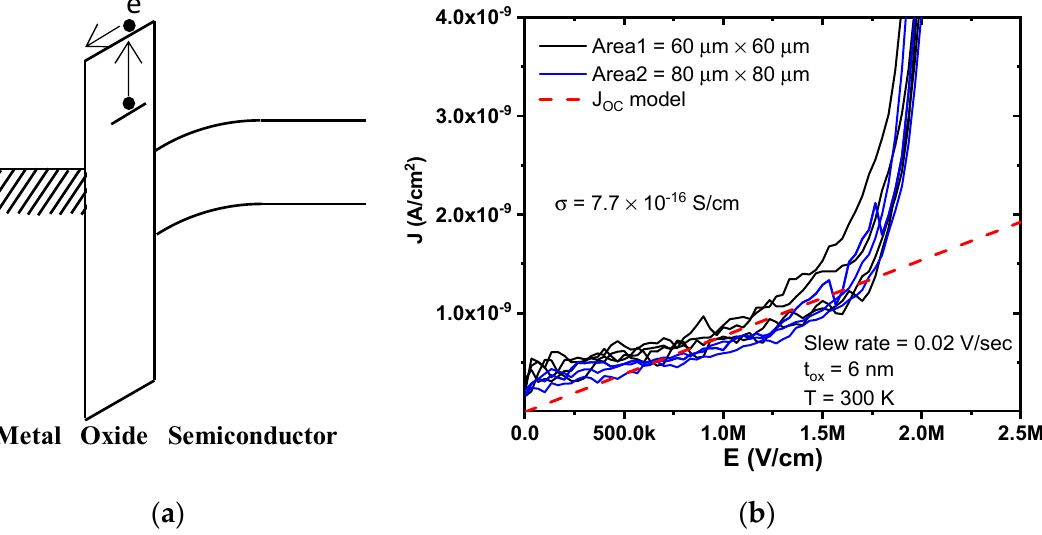
Figure 3. ( a ) Band energy diagram for ohmic conduction mechanism, and ( b ) comparison of J - E curves from measured data and ohmic conduction model at low electric fields.